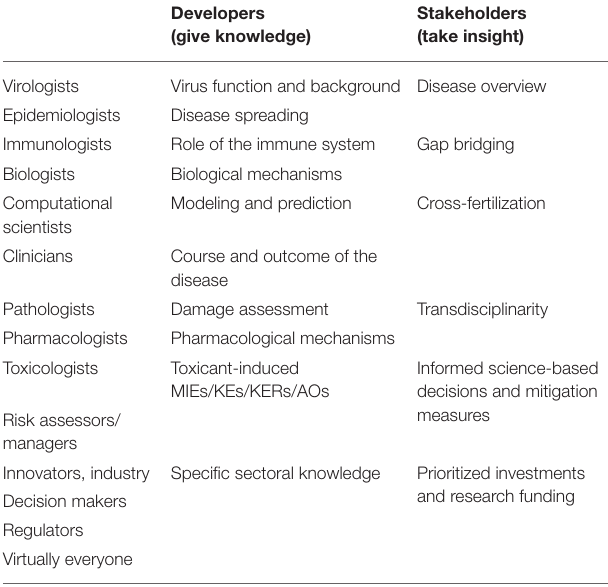
TABLE 1 | Multi-disciplinary range of COVID-19 AOP developers and